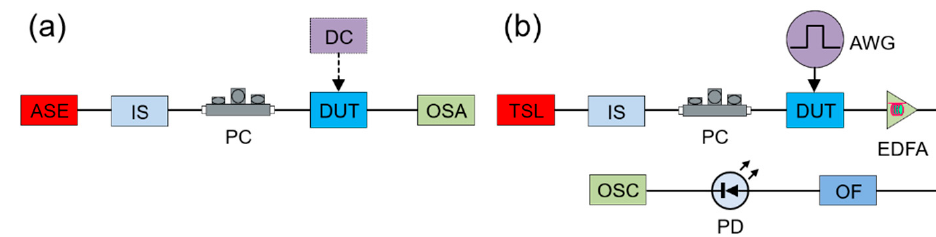
Figure 3. ( a , b ) Block diagrams of the experimental setups for the characterization of the phase shift- ers. ASE, amplified spontaneous emission optical source; IS, optical isolator; PC, polarization con- troller; DUT, device under test; OSA, optical spectrum analyzer; DC, direct current source; TSL, tunable laser source; AWG, arbitrary waveform generator; EDFA, erbium-doped optical fiber am- plifier; OF, optical filter; PD, photodiode; OSC, Oscilloscope.